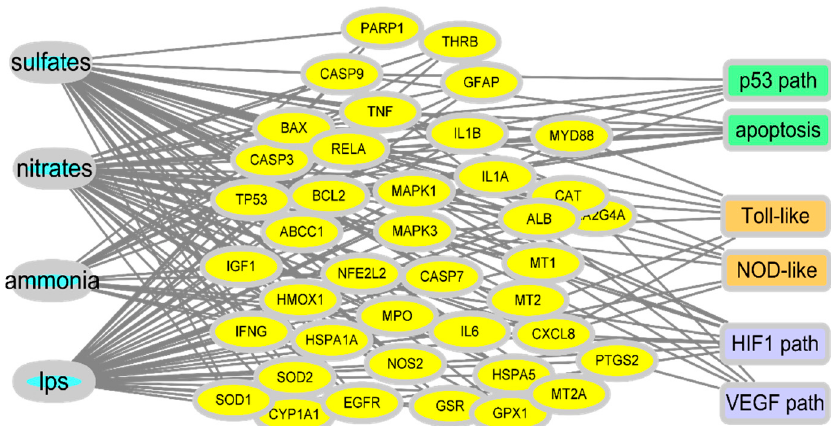
Figure 1. Prediction of gene network in PM-exposed mucosa. Gene expression profiles in the comparative toxicogenomic database in response to oxidation products of the primary gases and endotoxins as a representative microbial product. Based on PM exposure-linked gene sets, Kyoto Encyclopedia of Genes and Genomes (KEGG) analysis was performed to predict events in the insulted tissues.